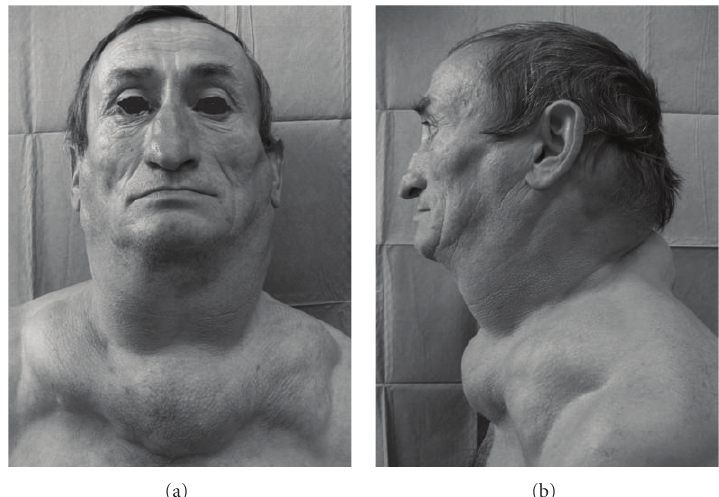
Figure 3: Preoperative frontal and lateral view of subject 3 with evidence of fat masses located in anterior and posterior neck, and upper trunk.